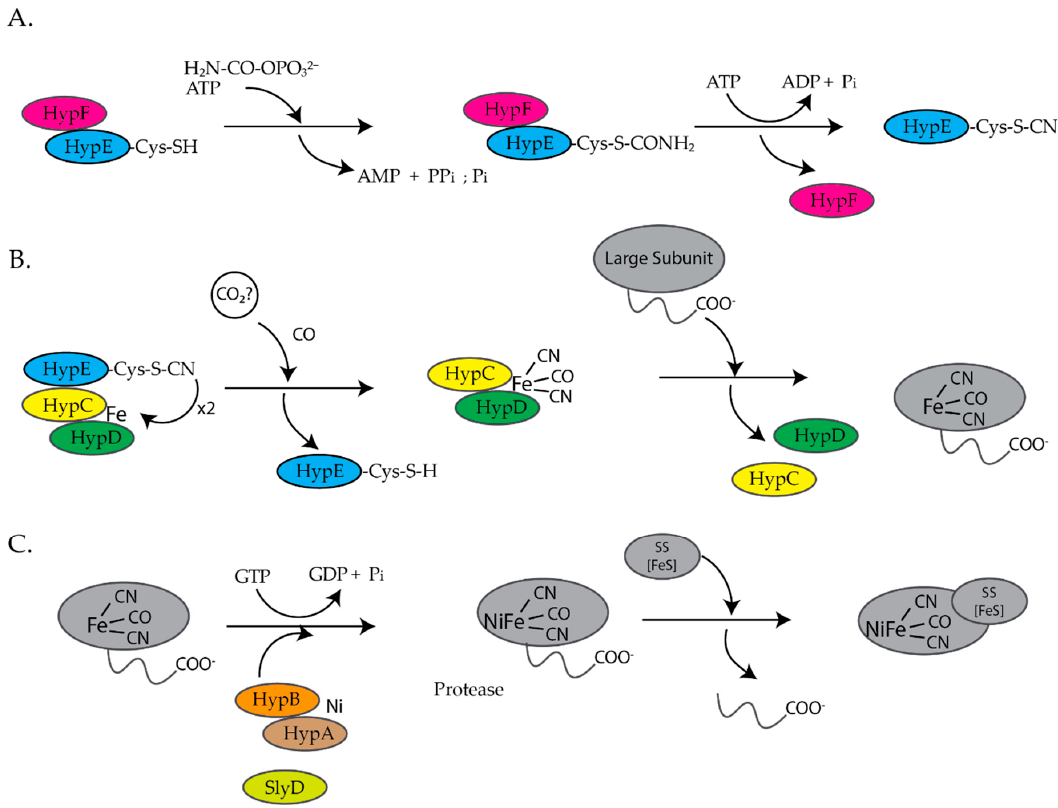
Figure 1. Model for the assembly [NiFe]-hydrogenase [12,13,17,20]. ( A ) HypE and HypF synthesize the cyanide ligands from carbamoylphosphate. ( B ) The assembly of the iron cofactor, Fe(CN) 2 CO, and delivery to the precursor large subunit of [NiFe}]-hydrogenase. ( C ) Nickel delivery and insertion into the large, precursor subunit of [NiFe]-hydrogenase and the peptide on the C-terminus of the large subunit is processed. The large subunit associates with the small subunit (SS) forming the mature [NiFe]-hydrogenase.